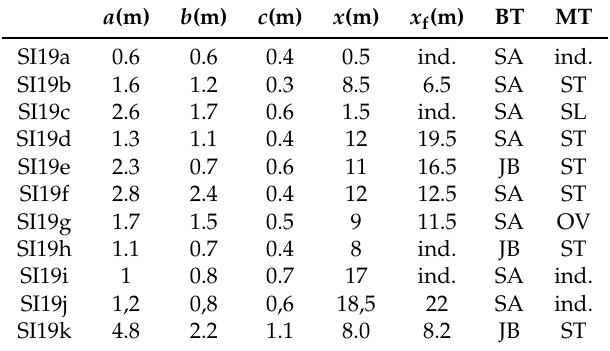
Table 3. Dimensions of the boulder axes a , b , c , pre-storm distances from the cliff x , post-storm distances from the cliff x f . BT, boulder type: JB, joint-bounded; SA, sub-aerial (not joint-bounded). MT, movement type: ST, saltation; SL, sliding; OV, overturning; ind., indeterminable. a (m) b (m) c